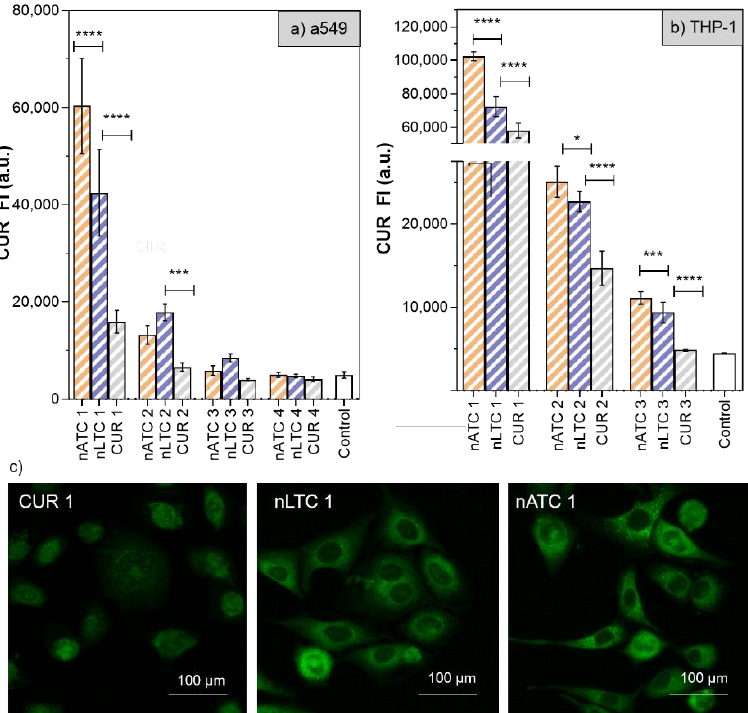
Figure 8. CUR internalization after 24 h incubation of free CUR and CUR nanovesicles on ( a ) A549 and ( b ) THP-1 cells. (1) CUR 20 µg/mL — total lipids 1.4 mg/mL, (2) CUR 10 µg/mL — total lipids 0.7 mg/mL, (3) CUR 5 µg/mL — total lipids 0.35 mg/mL. Values were analysed using a one-way ANOVA, * p < 0.05; *** p < 0.001, **** p < 0.0001). ( c ) representative images of fluorescence microscopy of intracellular CUR on A549 cells.